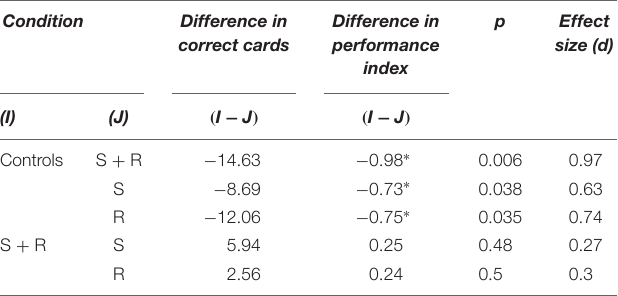
TABLE 2 | Mean differences between groups on problem-solving outcomes over all trials. Condition